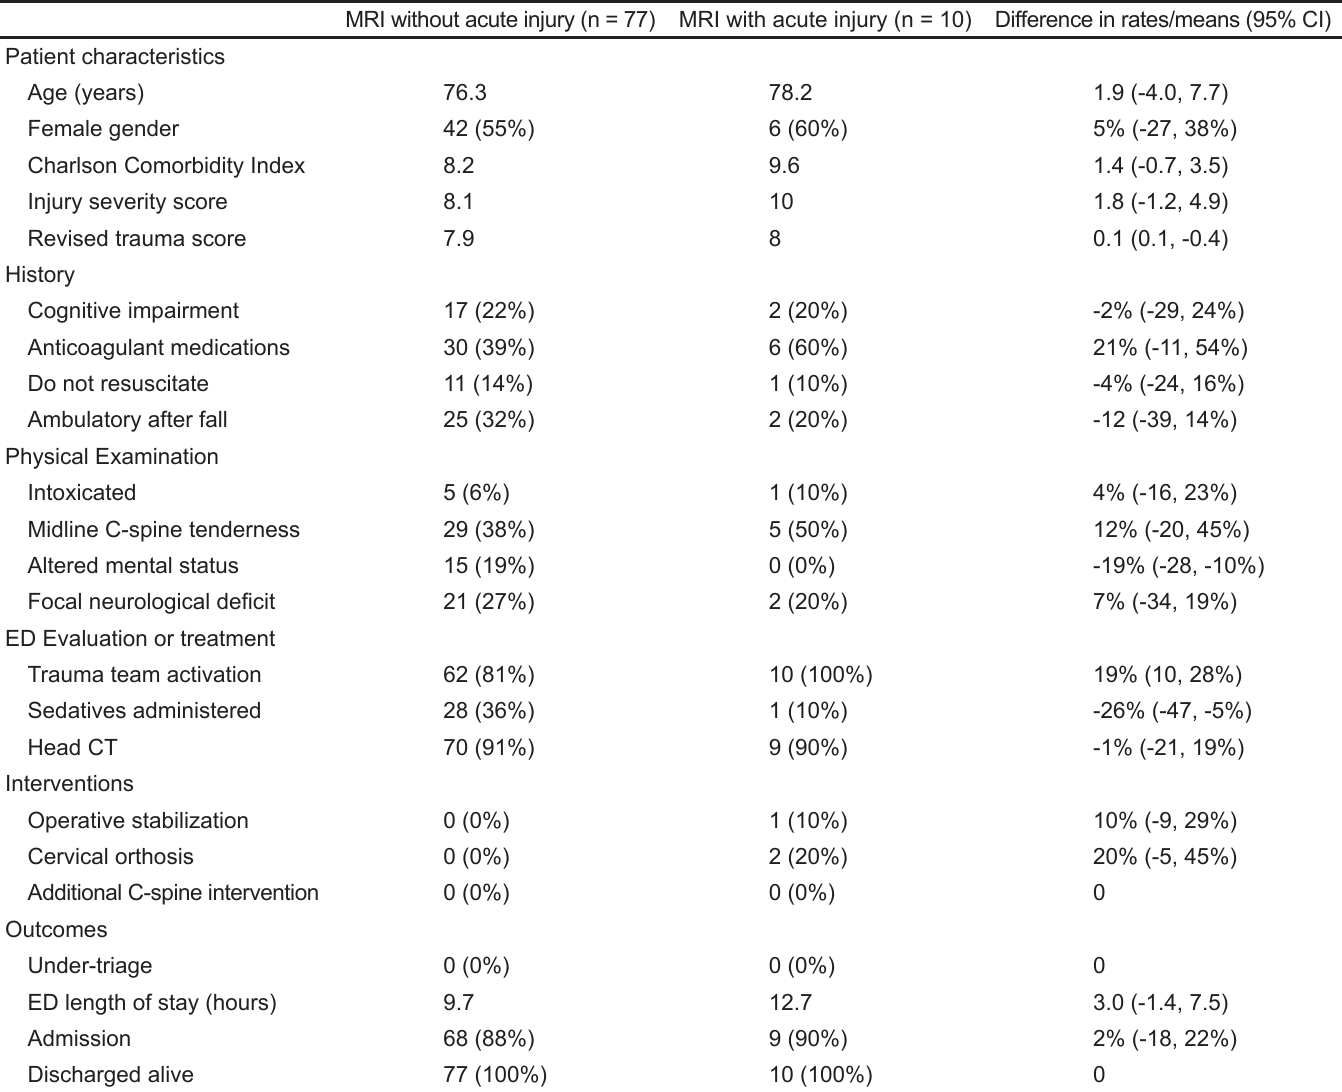
Table 1. Patient characteristics of cervical spine magnetic resonance imaging ordered from the emergency department following a ground-level